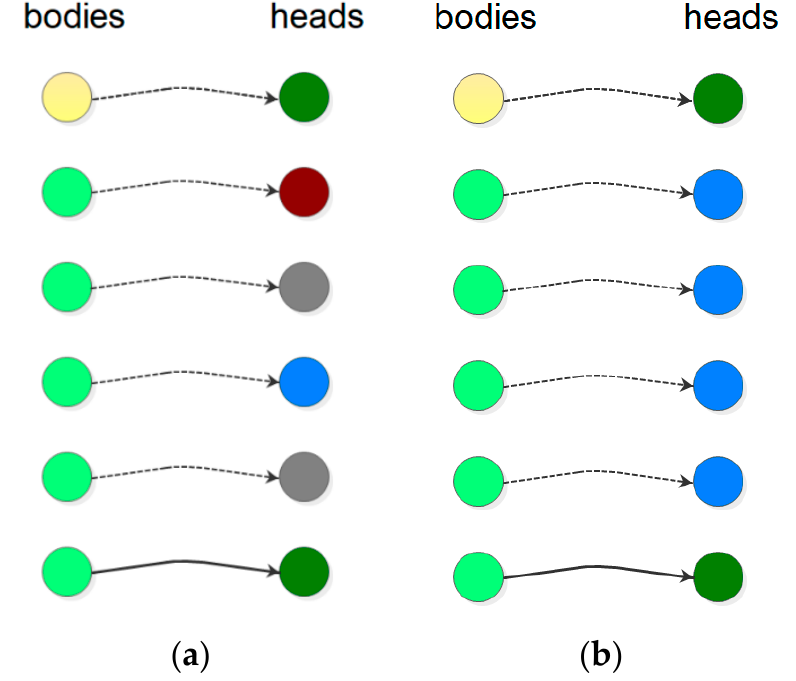
Figure 5. Two different exemplary datasets ( a , b ) with the rules of the same confidence of 20% and support of 16.7%, and lift of 1. The rule: if light green, then dark green.